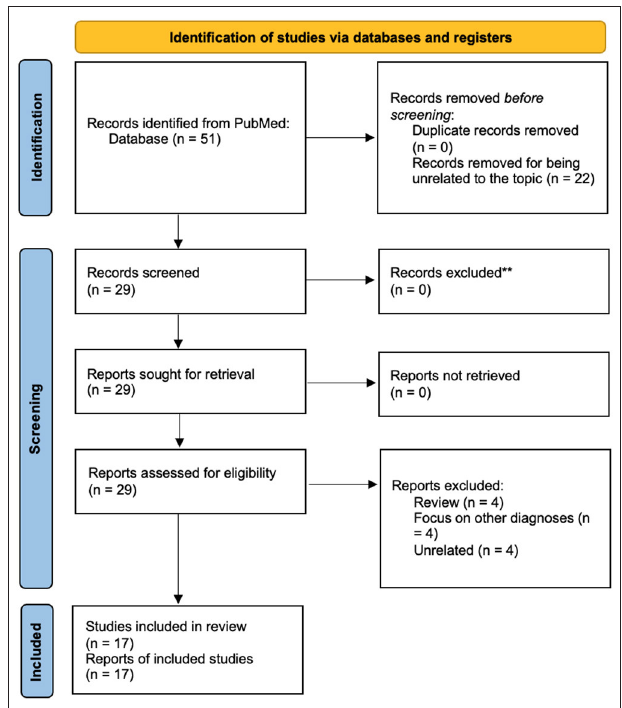
FIGURE 1 | PRISMA 2020 flow diagram of the systematic review. For more information visit: